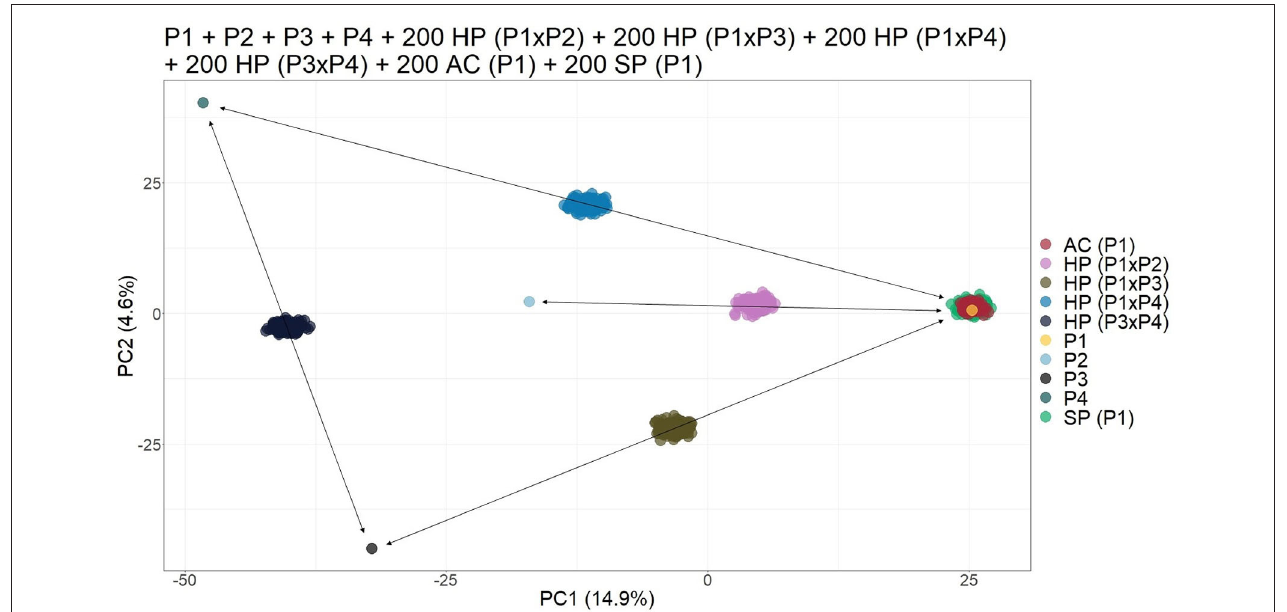
FIGURE 3 | Principal component analysis (PCA)-based scatter plot showing the simulated population composed of four parents (P1, P2, P3, and P4), 200 apomictic clones (ACs) (P1), 200 self-fertilization progenies -(SPs) (P1), 200 half-siblings (HSs) (P1 × P2), and 200 hybrids (HPs) (P1 × P3, P1 × P4, and P3 × 43). The axis represents the first and second principal components, with 14.9% and 4.6% of the variance explained, respectively.